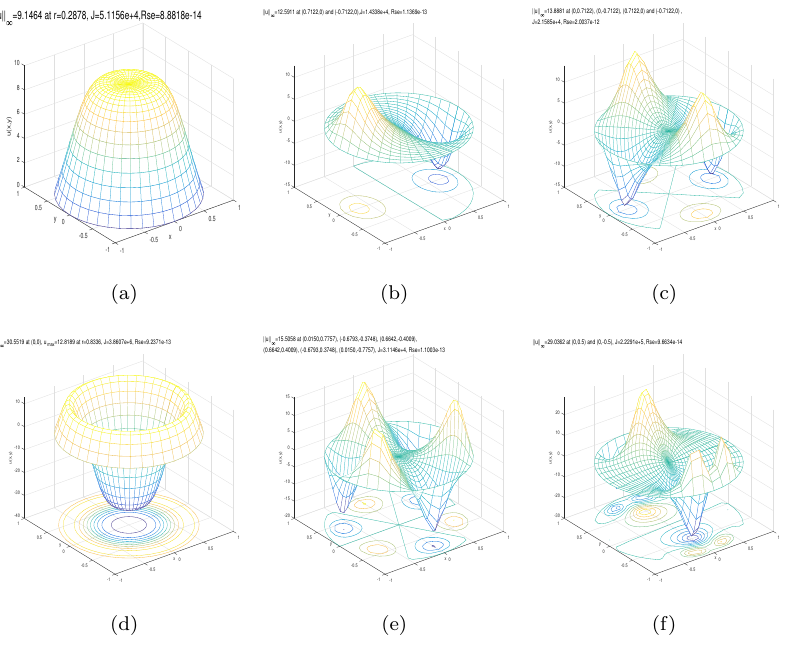
Figure 2. (a) λ 0 = 5 . 78449 , O (2) symmetry; (b) λ 0 = 14 . 67342 , Σ 1 symmetry; (c) λ 0 = 26 . 33997 , Σ d symmetry; (d) λ 0 = 30 . 46207 , O (2) symmetry; (e) λ 0 = 40 . 59751 , D 3 symmetry; (f) λ 0 = 57 . 31138 , Σ 1